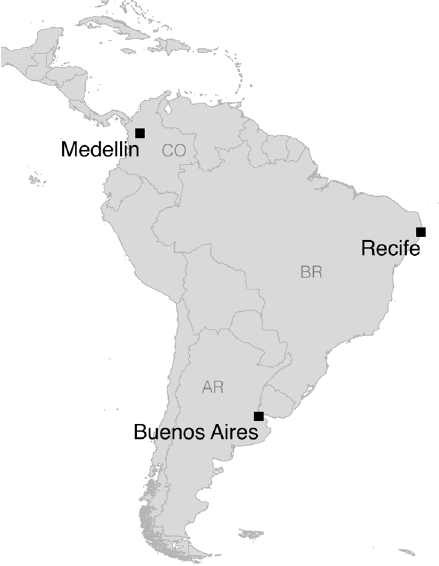
Figure 2. Cities included in the study.